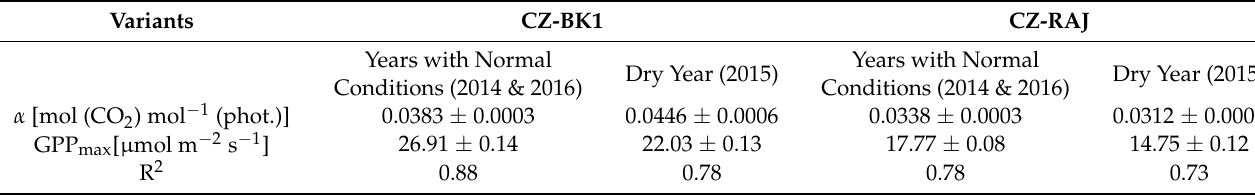
Figure 1. Histogram showing the frequency of occurrence of ( a ) vapour pressure deficit (VPD) and ( b ) soil volumetric water content (SVWC) conditions during May–September between years with normal conditions (dark colour) and drought stress (grey colour) in CZ-BK1 and CZ-RAJ. Table 6. Light response curve parameters for the normal (2014 and 2016) and dry (2015) years for the wet and dry climates (CZ-BK1 and CZ-RAJ respectively) within the main growing season period of May–September. The apparent quantum yield ( α ), the maximum gross primary production at light saturation (GPP max ) and the coefficient of determination (R 2 ) are also